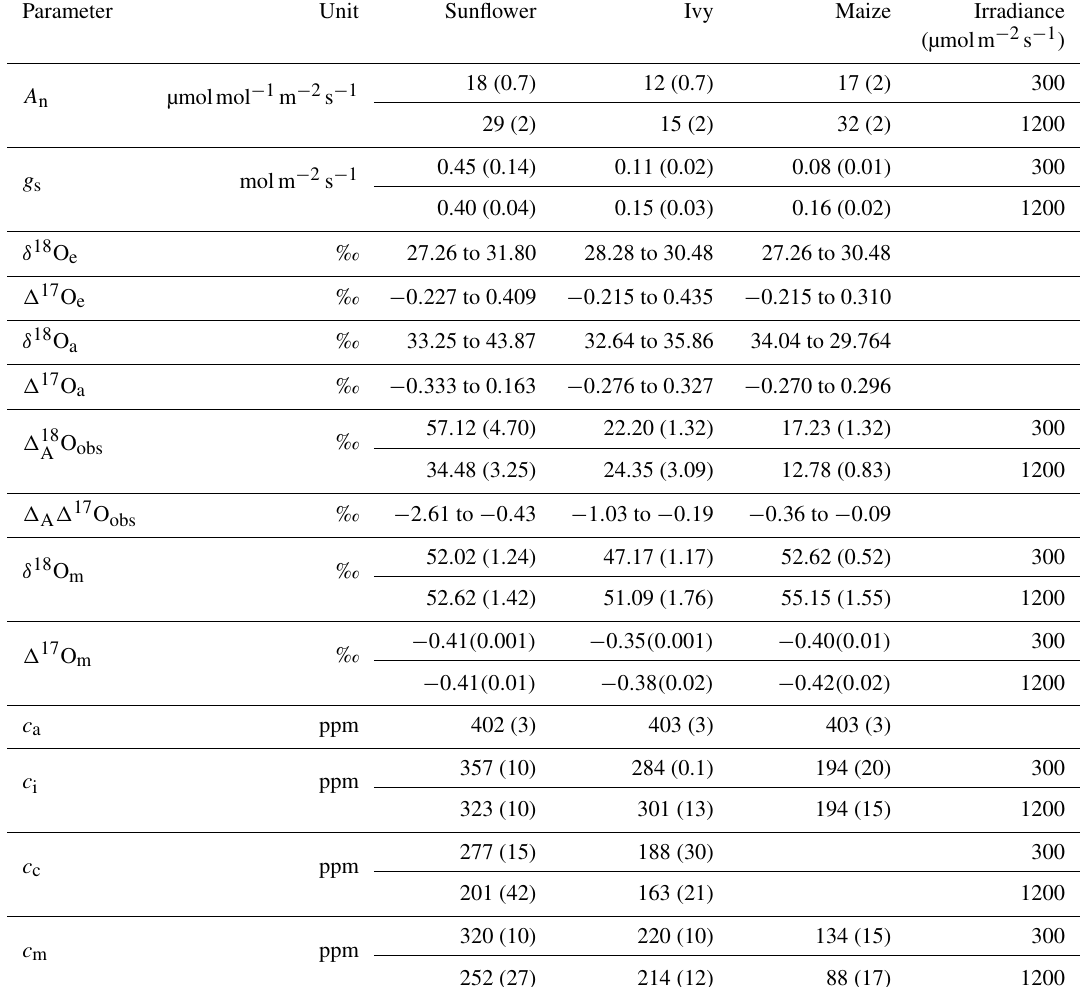
Table 1. Summary of gas exchange parameters and isotopic compositions of maize, sunflower, and ivy. Mole fraction at the site of exchange ( c m ) is calculated assuming complete isotopic equilibrium with the water at the CO 2 − H 2 O exchange site. The water at the CO 2 − H 2 O exchange site is assumed to be the same as the isotopic composition at the site of evaporation. Numbers in parentheses are the standard deviations of the mean (1 σ ).